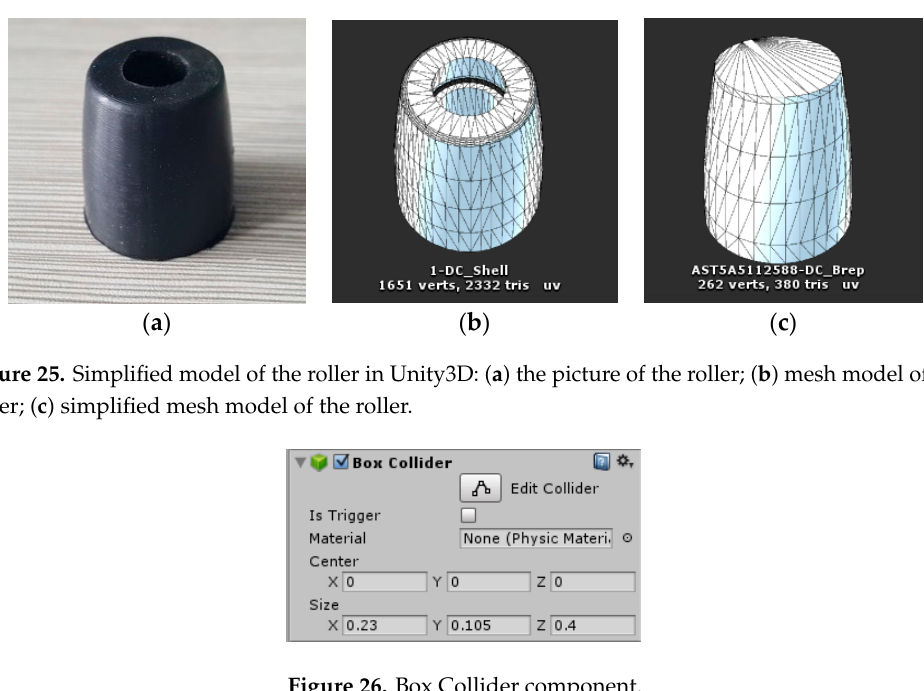
( c ) Figure 28. Rigid body components of the roller, hub, and main body: ( a ) rigid body component of the main body; ( b ) rigid body component of the hub; ( c ) rigid body component of the roller. 4.2.6. Adding Navigation Algorithm Scripts The navigation algorithm program was attached to the Unity object, and the variables of the program were connected to the corresponding objects in the Unity environment. In Unity, an empty object named A* was created to add a navigation algorithm program to the object. An empty object named “end” was created in Unity, and the position of the object was the position of the target point of the robot. Firstly, the “Grid” program was added to the A* object, and the main body of the robot was assigned to the “Robot” parameter. The “end” object was assigned to the End Point parameter, and the value of the Node Radius was temporarily set to 2, as shown in Figure 29a. The smaller the Node Radius value and the smaller the grid, the more accurate the navigation algorithm and the more computational resources it consumes, so the selection needed to be appropriate. Then, the program Findpath was added to the A* object, and the main body of the robot was assigned to the Robot parameter, and the “end” object created earlier was assigned to the End Point parameter, as shown in Figure 29b. Finally, the Navigation program was added to the A* object, the main body of the robot was assigned to the Robot parameter, and the end object was assigned to the End Point parameter. The value of the Barrier Distance was set according to the geometric size of the robot. The “speed” parameter was used to set the moving speed of the robot, where the value of the tentative variable was 0.2. The four hubs of the robot were assigned as “Wheel” parameters. ( a )